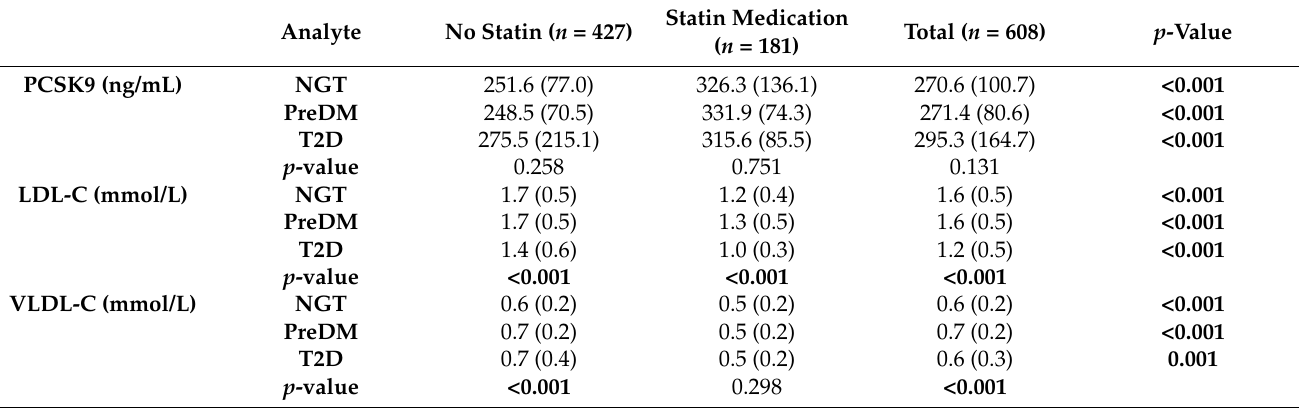
(Table 2). Under statins, LDL-C and VLDL-C levels were significantly decreased in subjects in each group ( p < 0.001 or 0.001, Table 2). Table 2. The effect of statin medication of circulating PCSK9 (based on ELISA measurements), LDL-C and VLDL-C levels (based on NMR metabolomics measurements) in NGT, PreDM and T2D